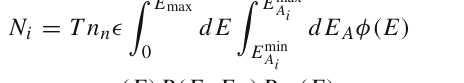
Table 4 Total signal and background event rates for DUNE and T2HK set-ups assuming NO, δ CP = 248 ◦ , and sin 2 θ 23 = 0.425. For all other oscillation parameters, we take the best fit values corresponding to NO